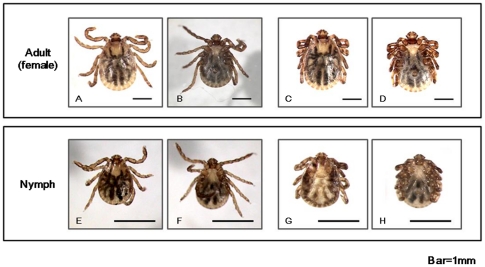
Photograph of adult and nymph H. flava.(A and B) Photograph of a living adult female. Back and abdomen are shown. (C and D) A dead adult female. (E and F) A living nymph. (G and H) A dead nymph.